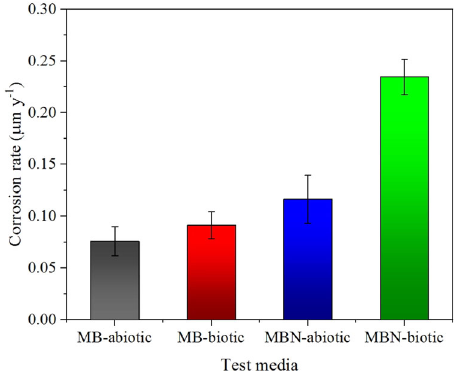
Fig. 6 Corrosion rates of creviced coupons calculated from mass loss. Corrosion rates of creviced 304 stainless steel coupons after